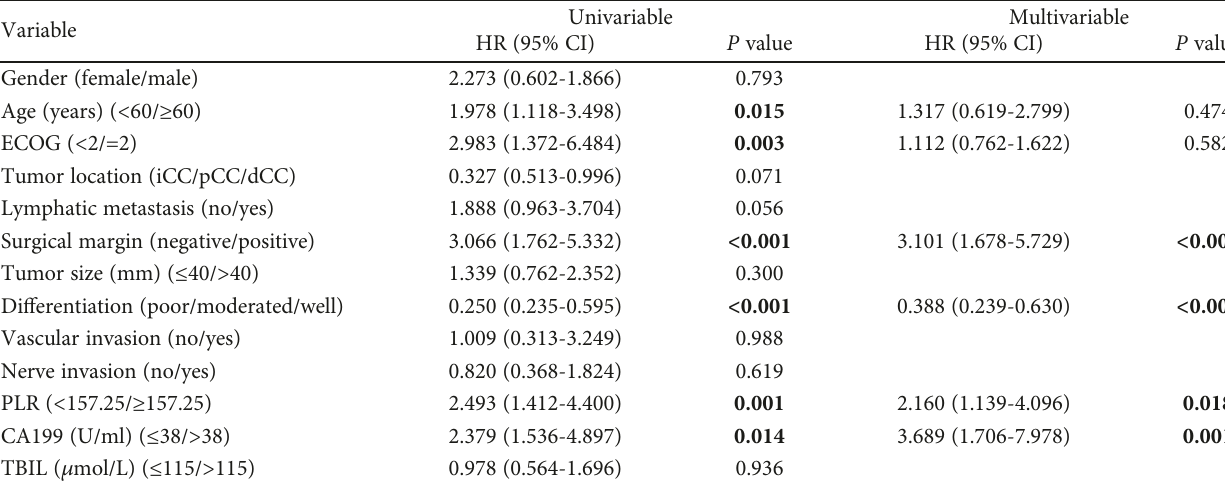
Abbreviations: PLR: platelet-lymphocyte ratio; ECOG: Eastern Cooperative Oncology Group; iCC: intrahepatic cholangiocarcinoma; pCC: perihilar cholangiocarcinoma; dCC: distal cholangiocarcinoma; CA199: carbohydrate antigen 19-9; TBIL: total bilirubin; HR: hazard ratio; CI: con fi dence; P < 0 05 was considered signi fi cant. Table 4: Kaplan – Meier method and Cox proportional hazard regression analysis of patients ’ progression-free survival.